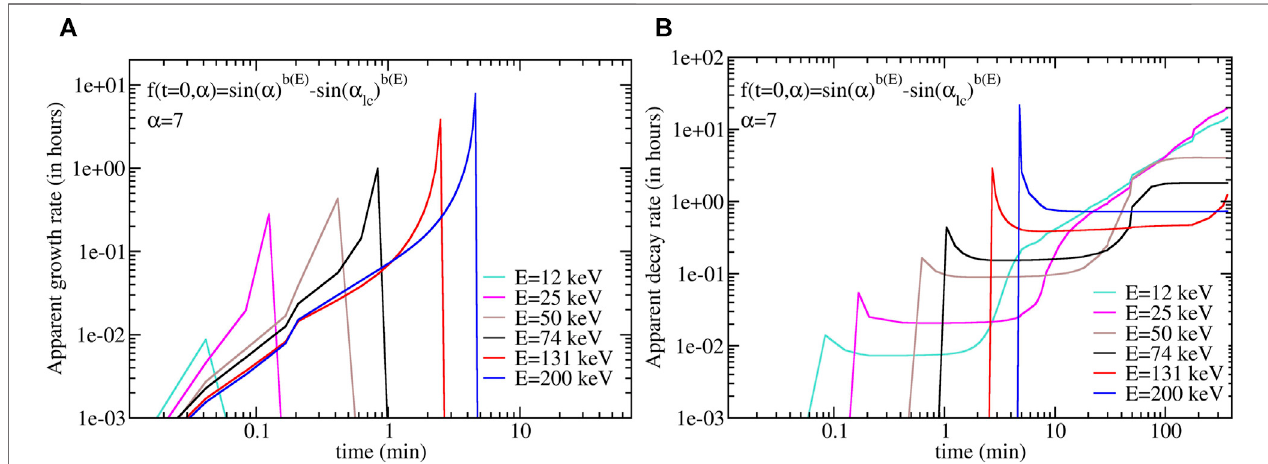
FIGURE10 | Evolution ofthe instantaneous growth ( τ > 0) (A) and decay ( τ < 0) (B) timescales, de fi ned as1/ τ ( t ) (cid:1) − Δ f ( t )/ Δ t , forpitchangleinthe vicinity ofthe loss cone.Thegrowth existsduring the fi ve fi rstminutes andisentirelyduetotheinitialcondition,favored bytheabsenceofanabruptgradient atthelosscone,whichallows the low pitch angle population to be populated from higher pitch angle electrons diffusing toward the loss cone.